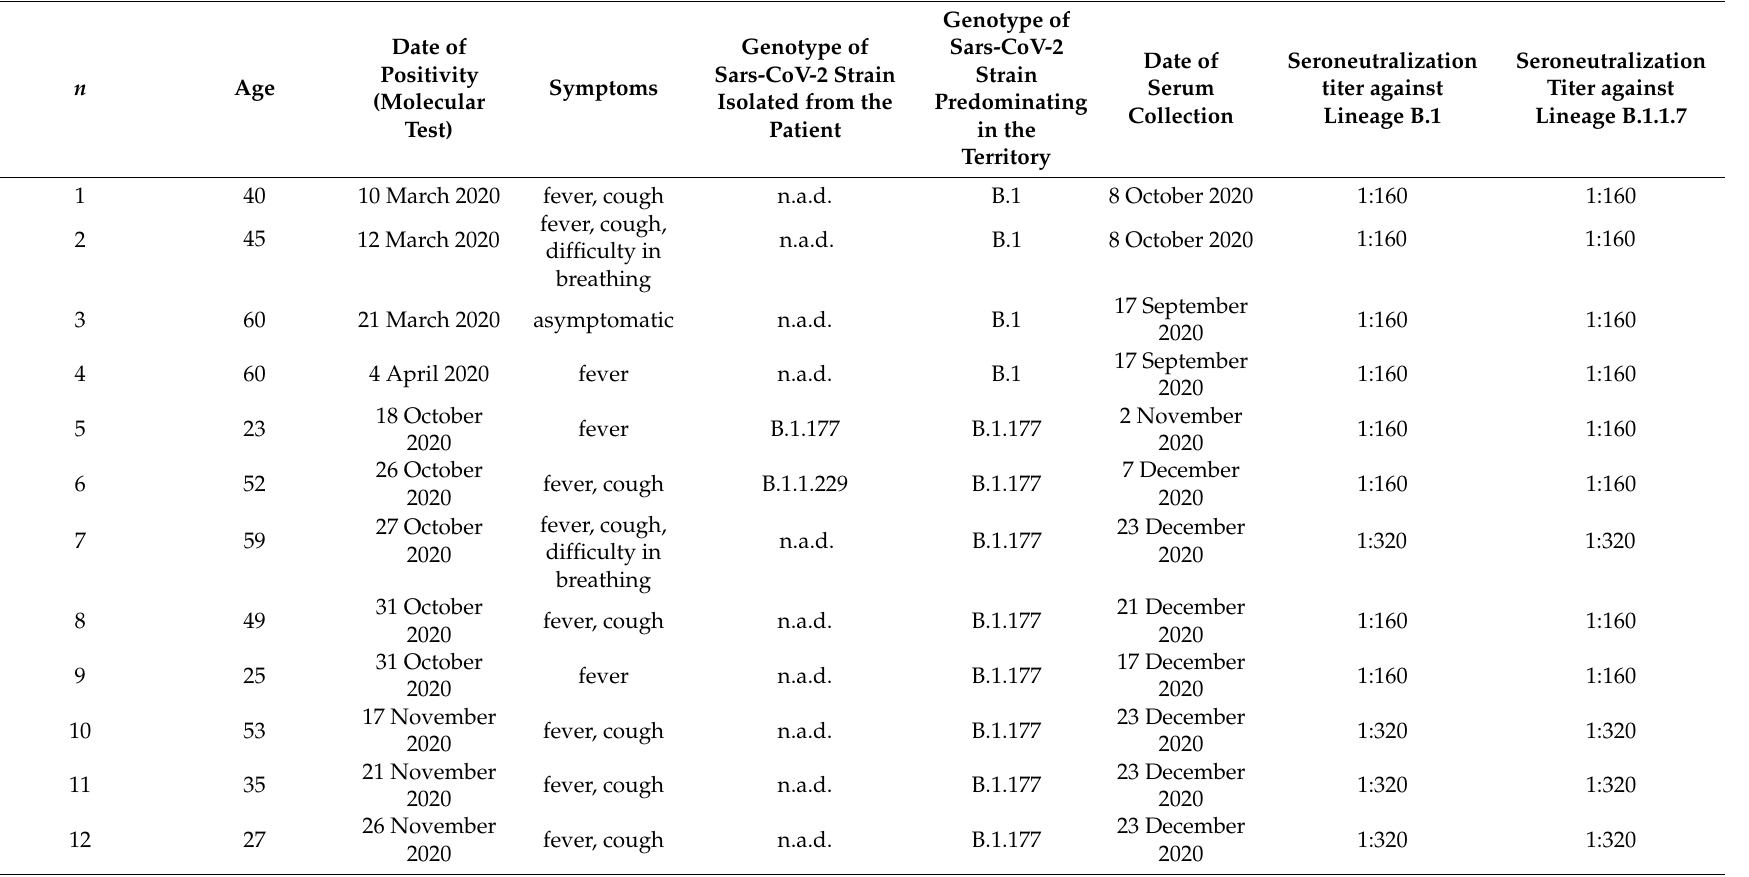
Table 1. Data of the analysed patients in this study and results of seroneutralization tests. The symptoms refer to the date of the first positive test. n.a.d. (not available